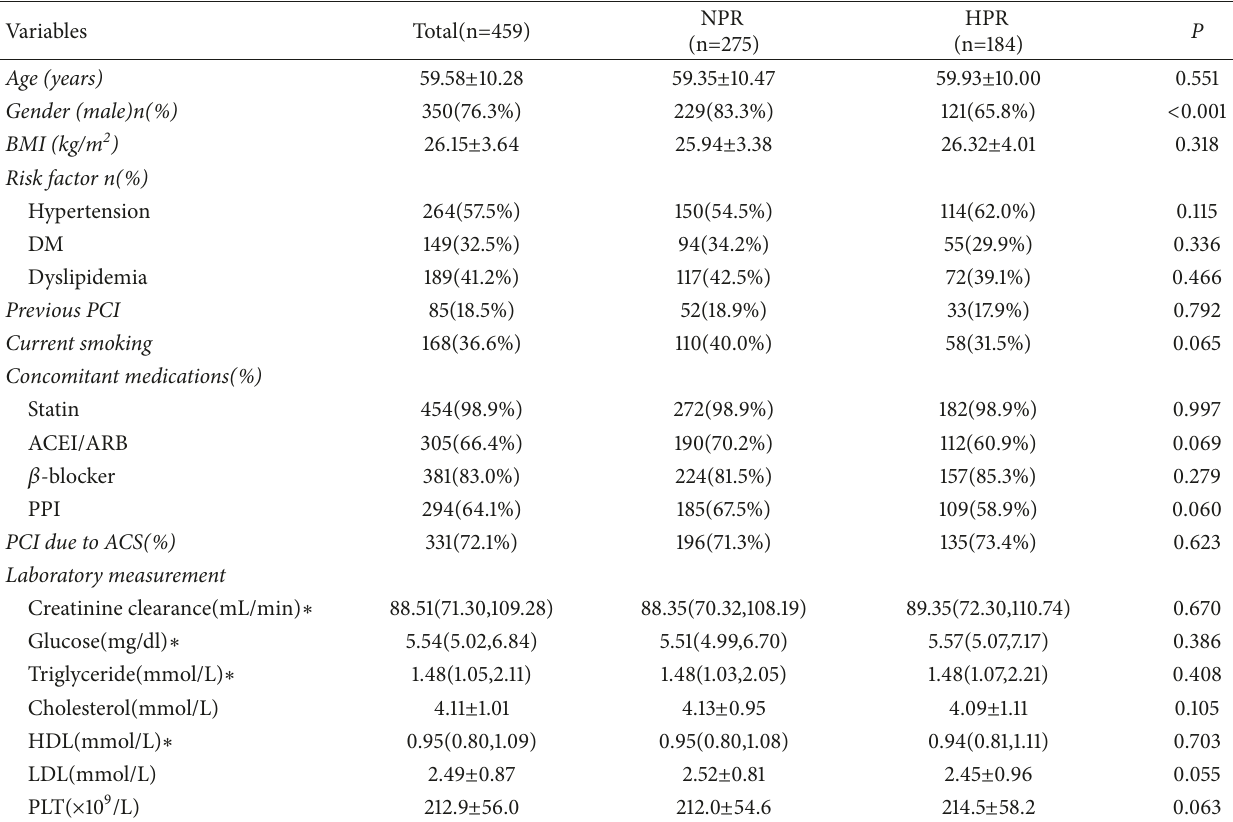
Table 1: Baseline characteristics of the study